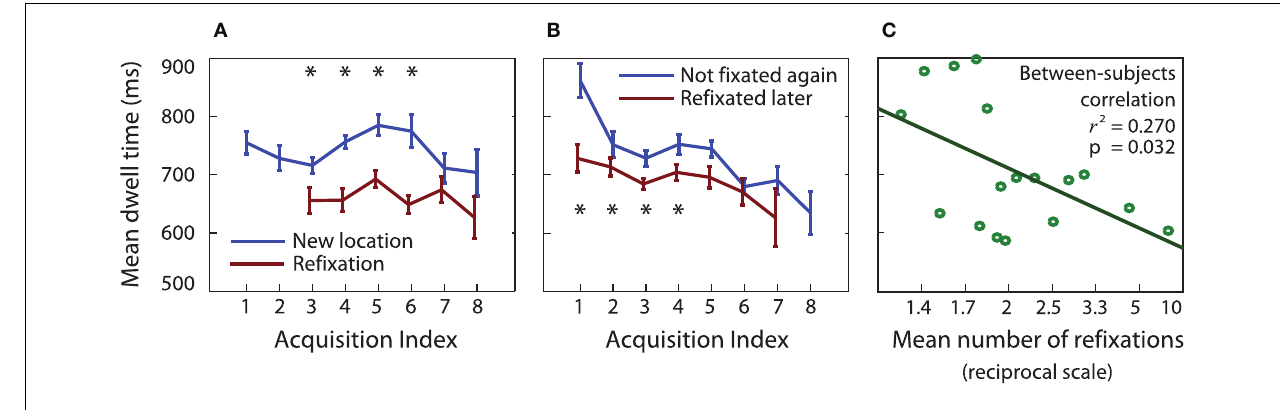
FIGURE 6 | (A) Dwell times on previously unfixated items are longer than for previously fixated items (ANOVA main effect of previous refixation, p < 0 . 01; pairwise t -tests p < 0 . 01 at acquisitions 3–6). (B) Dwell times are longer when the item is never fixated